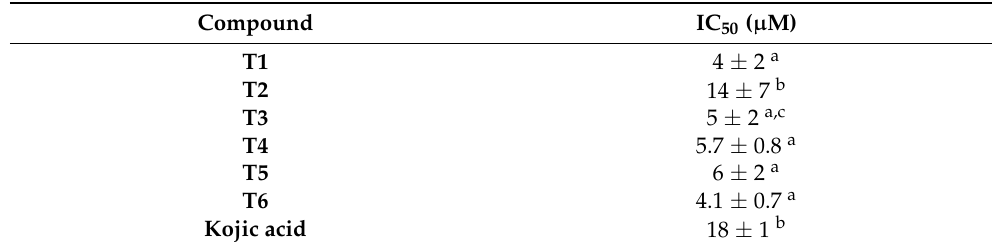
Table 2. IC 50 values for the studied compounds determined from the tyrosinase assay. Kojic acid was used as the reference compound. Compound IC 50 ( µ M) T1